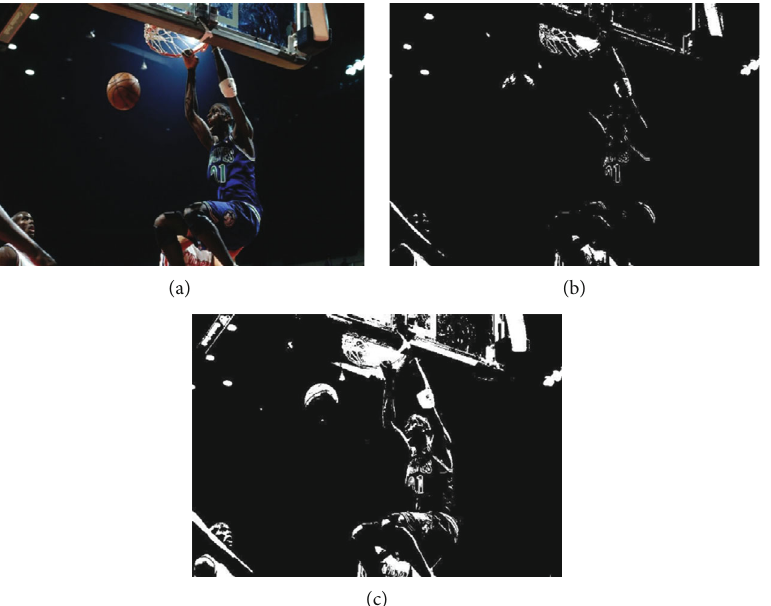
Figure 3: Watershed video image segmentation in nonlinear scale space: (a) original image; (b) the result of original image after watershed segmentation; (c) the result of original image after 30 iterations of forward-backward di ff usion and watershed